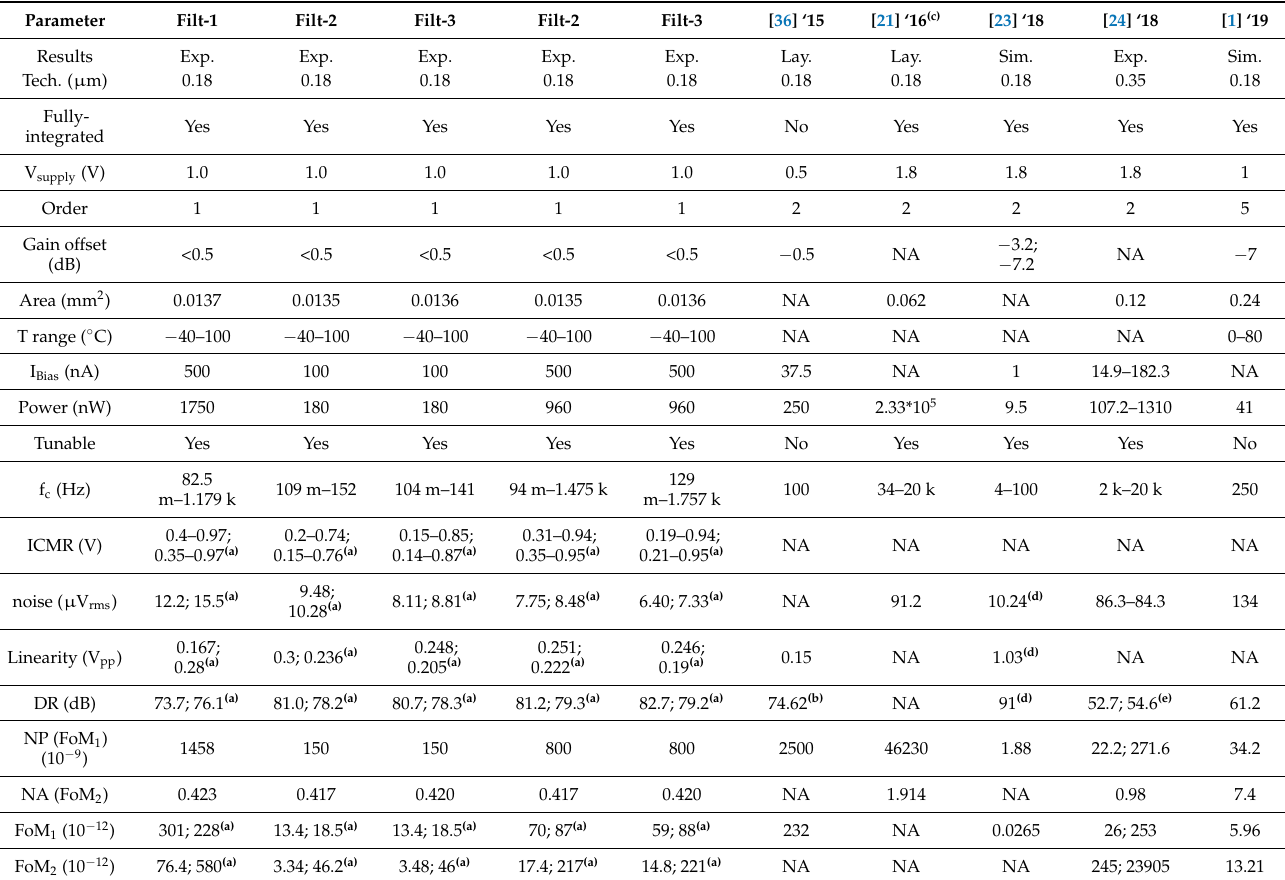
Table 2. LPF performance comparison with similar G m –C